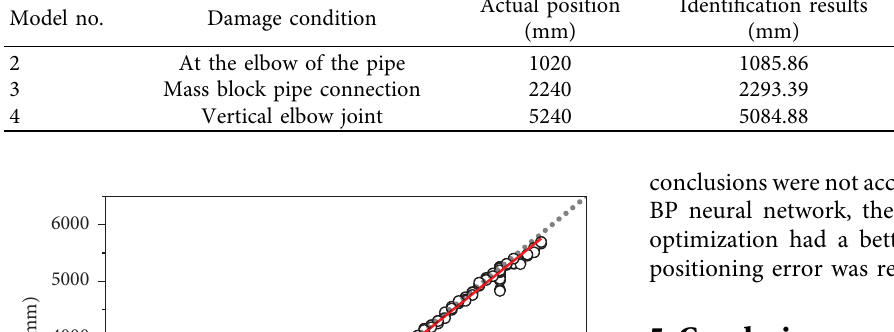
Table 13: GA BP neural network location results of the vibration test. Model no.